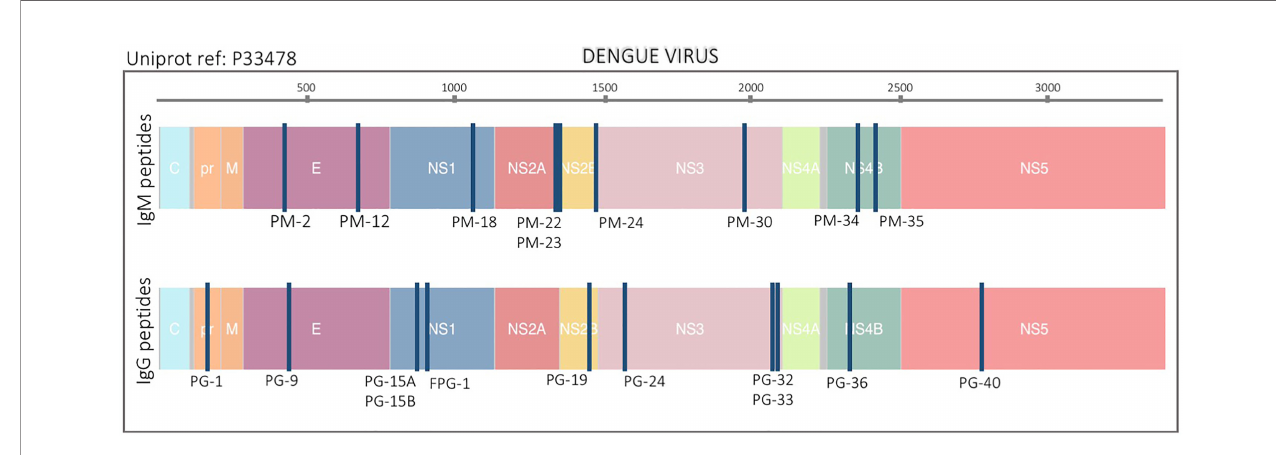
FIGURE 1 | Location of peptide biomarkers in the DENV proteome. Selected peptides are plotted relative to the polyprotein coordinates (start amino acid position) for DENV (P33478). Each blue vertical bar represents a single peptide. Top and bottom plots are IgM and IgG peptides respectively. Structural proteins: Capsid (C), Membrane (pr, M) and Envelope (E), and non-structural proteins: NS1, NS2A, NS2B, NS3, NS4A, NS4B, and NS5 are color coded. The peptide names are also indicated.